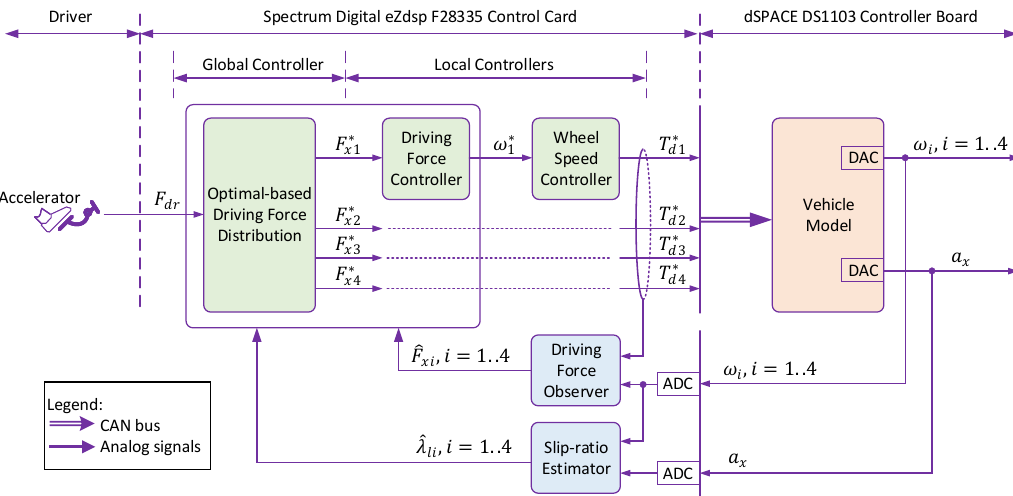
Figure 20. Configuration of Driving Force Distribution and Control for EV with Four In-Wheel Motors, adapted with implementation on the proposed HIL simulation